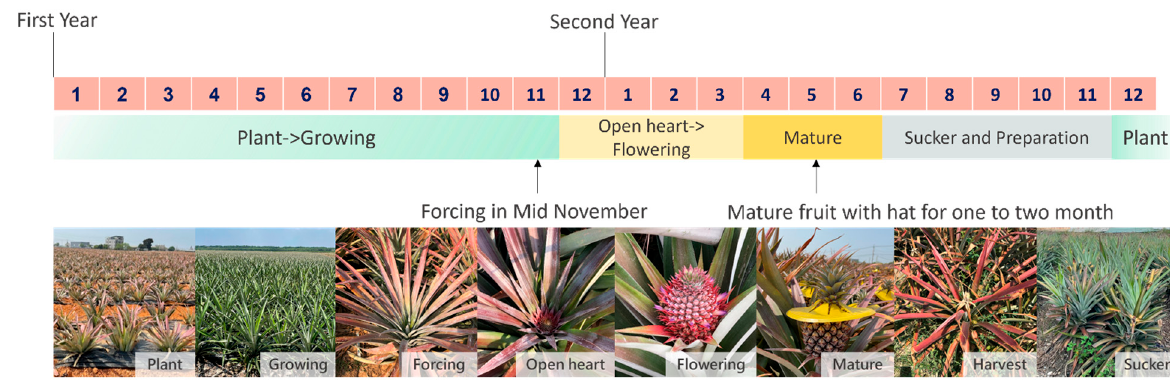
Figure 3. Photos of the three kinds of “sunscreen mature fruits” pineapples in the study area covered with: ( A ) plastic sheets of different colors; ( B ) yellow plastic covers; and ( C ) covered with nets. 2.3. Object Detection The model of Faster R-CNN can be divided into four parts (Figure 4): (a) Convolutional layers; (b) Region proposal networks (RPN); (c) ROI pooling; (d) A classifier, as described in the following section. Figure 4. The framework of pineapple detection with Faster R-CNN.